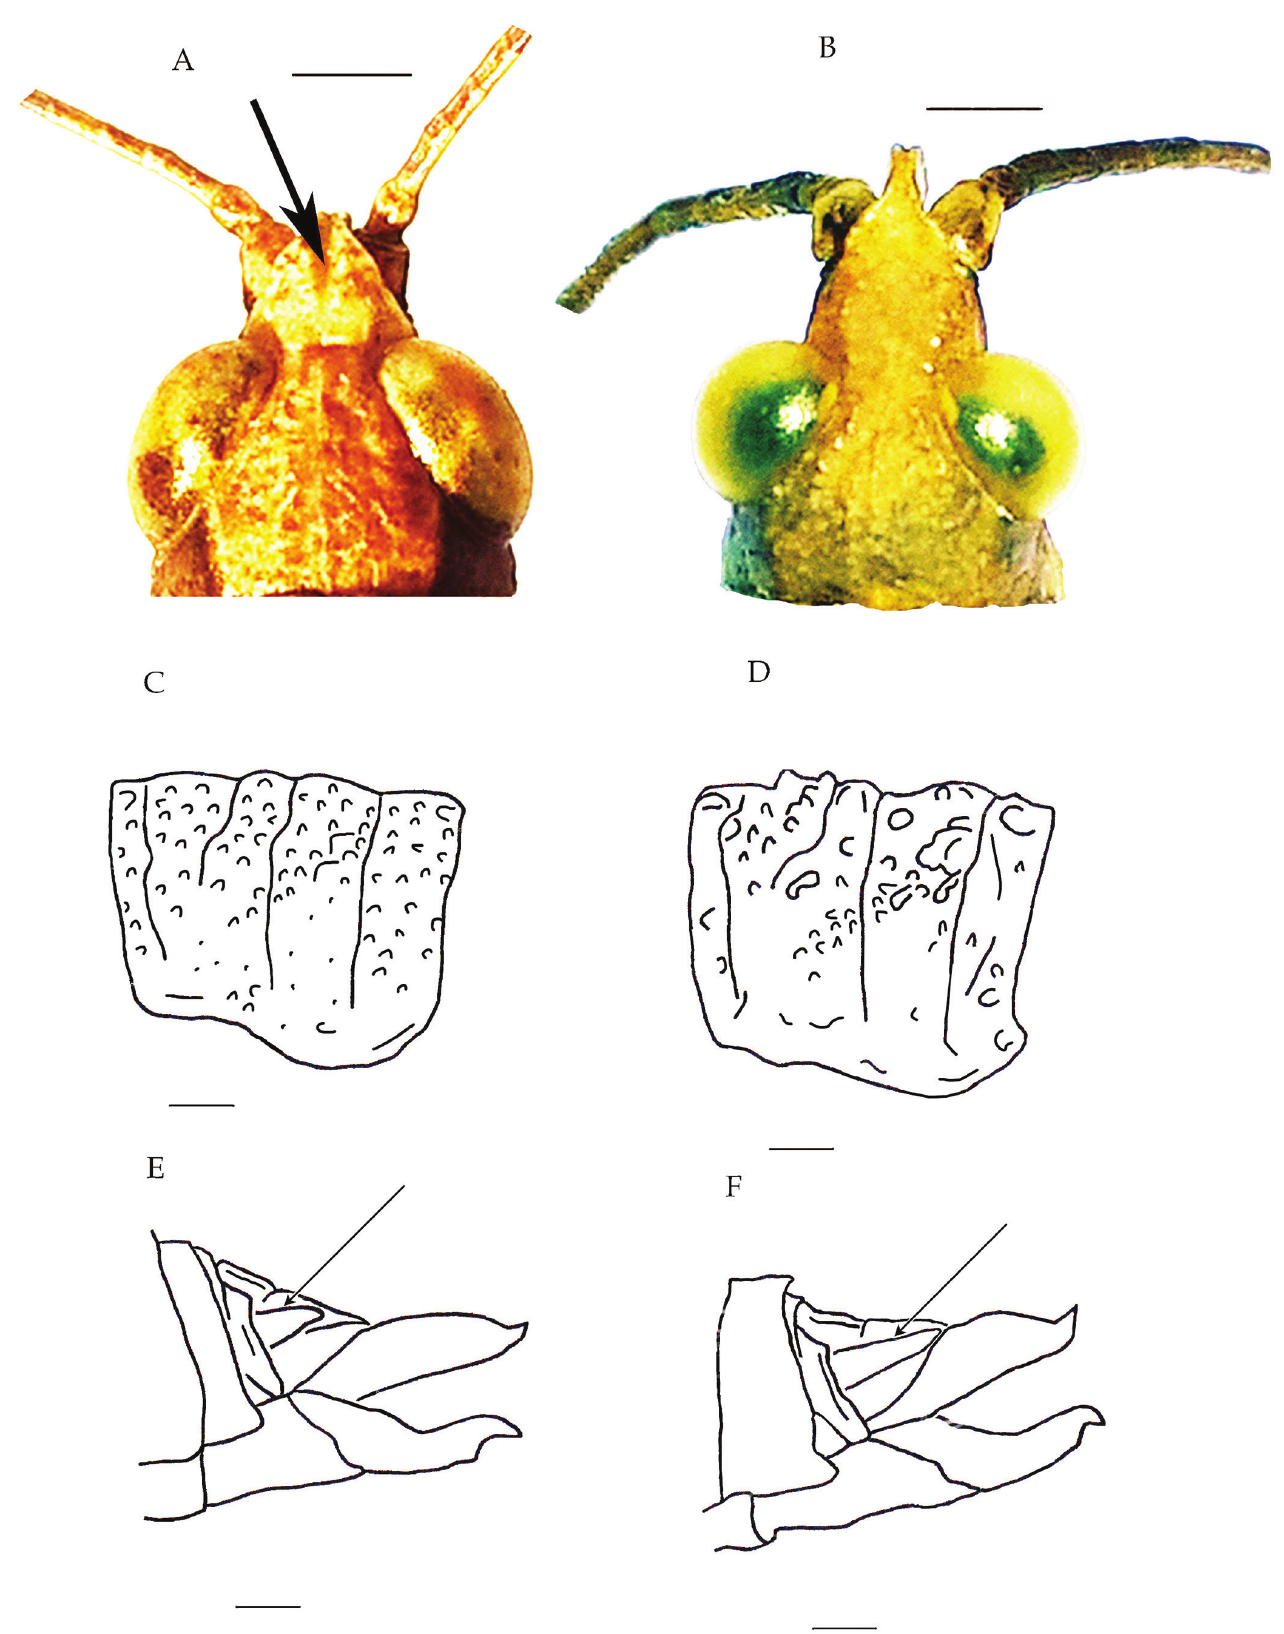
Fig. 6. External diagnostic characters of Gemeneta spp. A, B. Fastigium of vertex; C–D. Pronotum lateral view; E–F. External genitalia female; A, C, E. G. terrea and B, D, F. G. opilionoides . Scale bars = 1